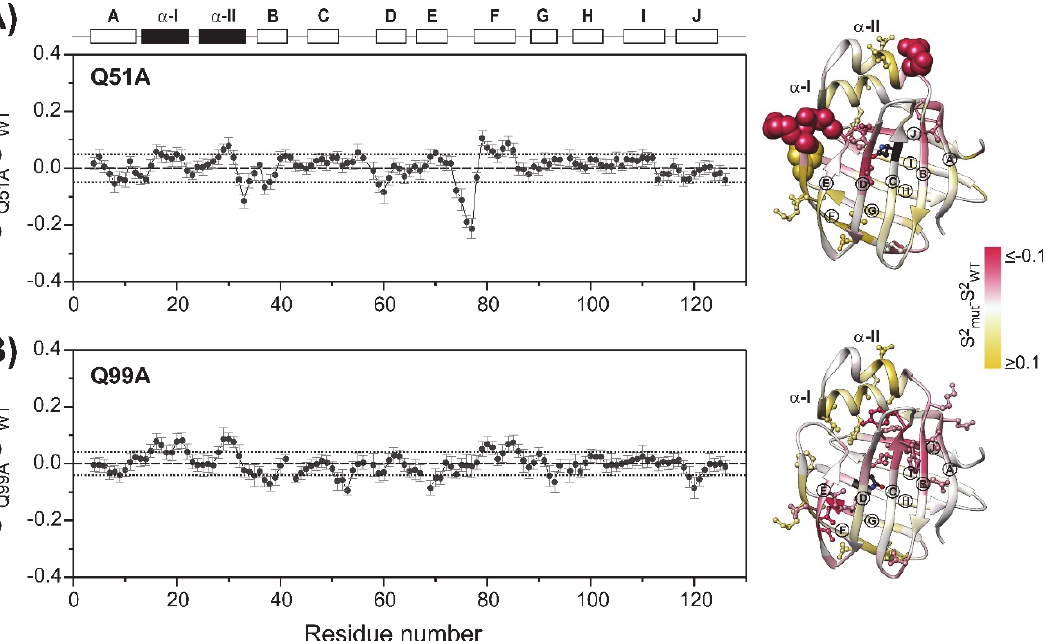
Figure 4. Differences in the ps ‐ ns flexibility of the protein backbone between wild ‐ type and ( A ) Q51A, ( B ) Q99A apo human I ‐ BABP (283 K) as determined from 15 N relaxation measurements. Differences in the generalized order parameter ( S 2 mut ‐ S 2 WT ) obtained from MF analysis were averaged for a window of three consecutive residues ( Δ S 2 * ) and shown as a function of the amino acid sequence. Secondary structural elements are indicated at the top. Values of Δ S 2 * mapped on the ribbon diagram of wild ‐ type human I ‐ BABP (PDB: 1O1U [15]) in a yellow ‐ to ‐ gray ‐ to ‐ red gradient are shown on the right. Residues exhibiting | Δ S 2 *| > 0.1 ppm (arbitrary limit) are highlighted as spheres, whereas those exceeding the mean by more than half of the standard deviation (dotted line) are shown in a ball ‐ and ‐ stick representation. β ‐ strands are labeled for better readability. The posi ‐ tion of the mutations is indicated in black.